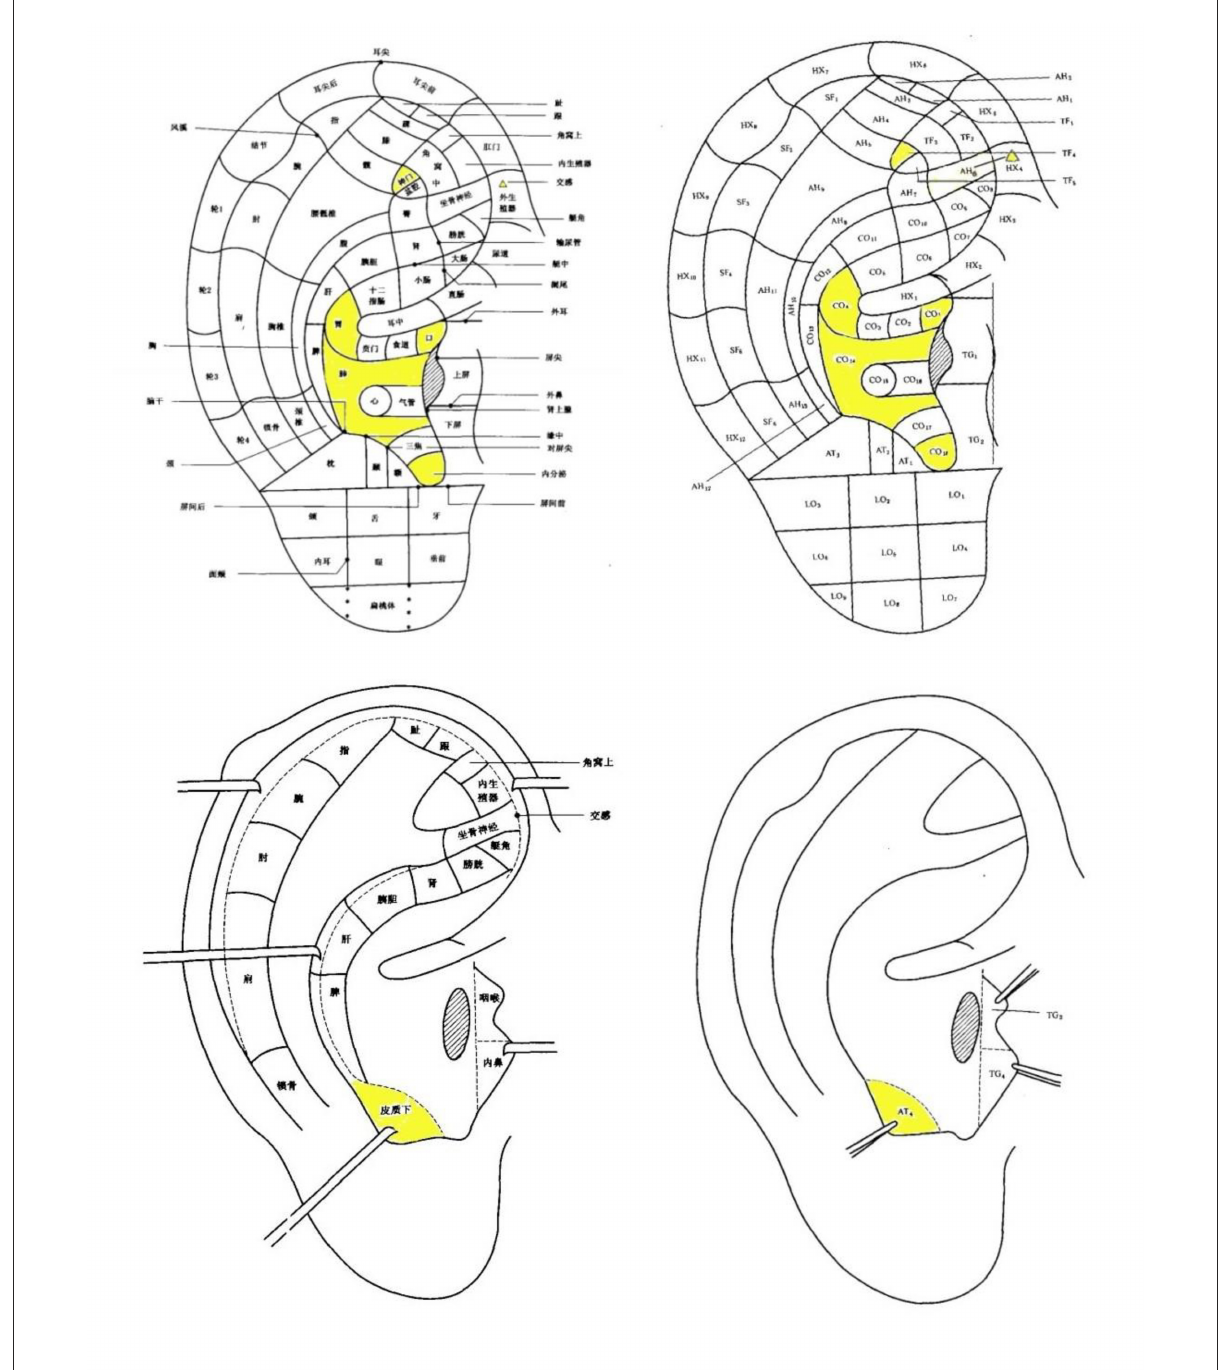
FIGURE3 Nomenclature and location of auricular points